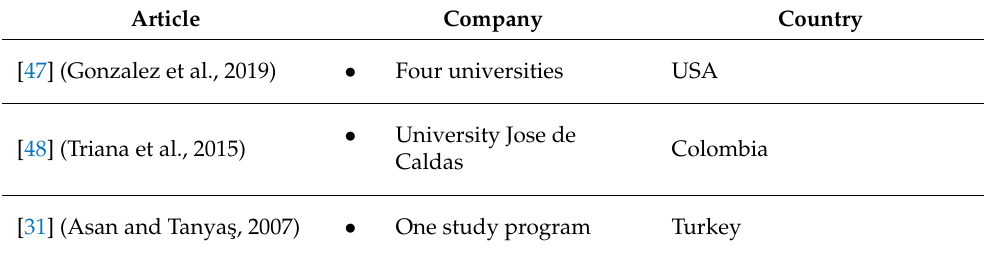
Table 8. Education organizations (sixth